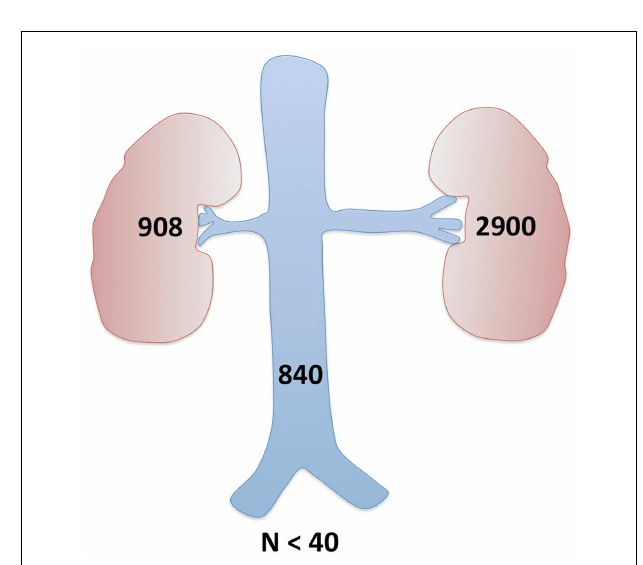
FIGURE 2 | Renal vein renin sampling with lateralization . Demonstration of the differential hormone levels between the main renal veins and elevation above systemic hormone levels (all above the upper limit of normal) confirmed the left kidney tumor as a source of excessive renin production.